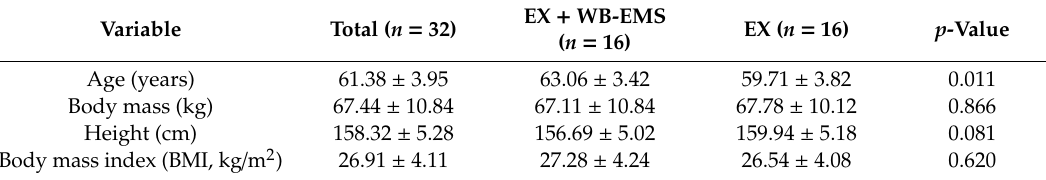
Table 1. Summary of sample characteristics.